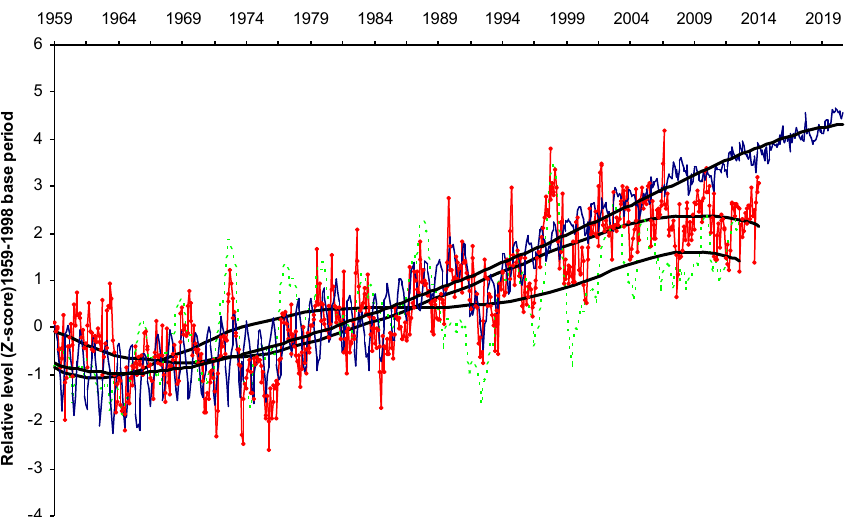
Figure 2. Z -scored monthly data: observed global surface temperature (green dashed curve) compared with that projected from an IPCC mid-range scenario global climate model (GCM) – the CMIP3, SRESA1B scenario run for the IPCC fourth assessment report (IPCC, 2007) (blue curve). Also shown is the trend in first-difference atmospheric CO 2 (smoothed by two 13-month moving averages) (red dotted curve). To show their core trends for illustrative purposes, the three series are fitted with fifth-order